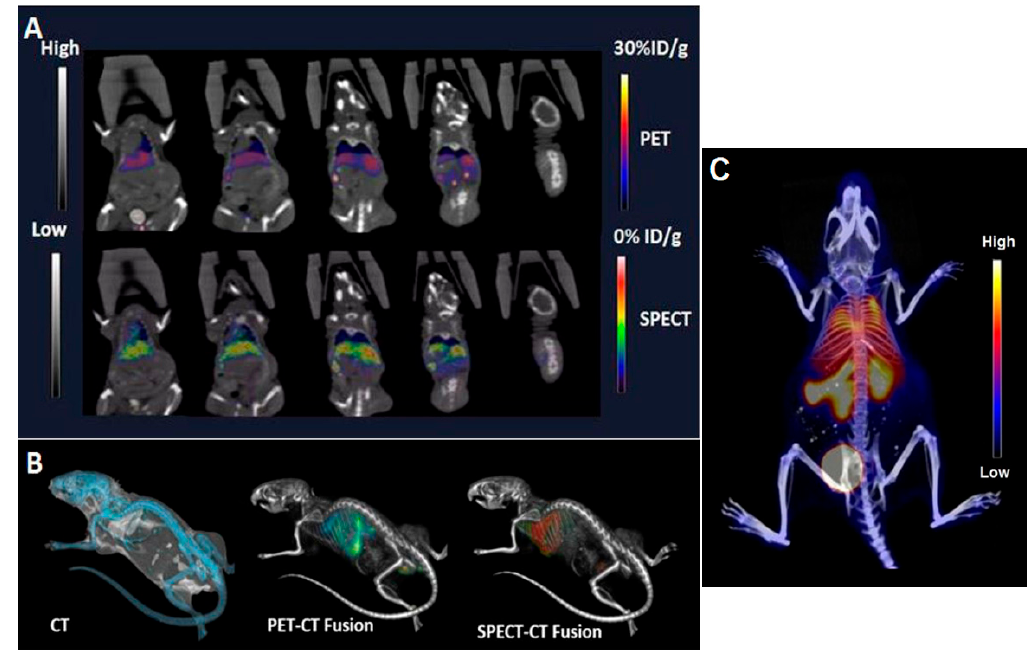
Figure 3. In vivo computed tomograpghy (CT), positron emission tomography (PET)/CT, and SPECT/CT images of a nude mouse injected with 14 MBq of [ 18 F]-FCP encapsulated [ 111 In]-Liposome through tail vein injection 1 h post-administration. Both PET/CT and SPECT/CT images show the uptake of [ 18 F]-FCP encapsulated in [ 111 In]-Liposome in the liver and spleen. Both images correspond to each other in the uptake profile, demonstrating the feasibility of dual-tracer imaging from a single nano-construct. ( A ) Coronal images, ( B ) volume rendered images, and ( C ) maximum intensity projection (MIP) image 1 h post-injection.